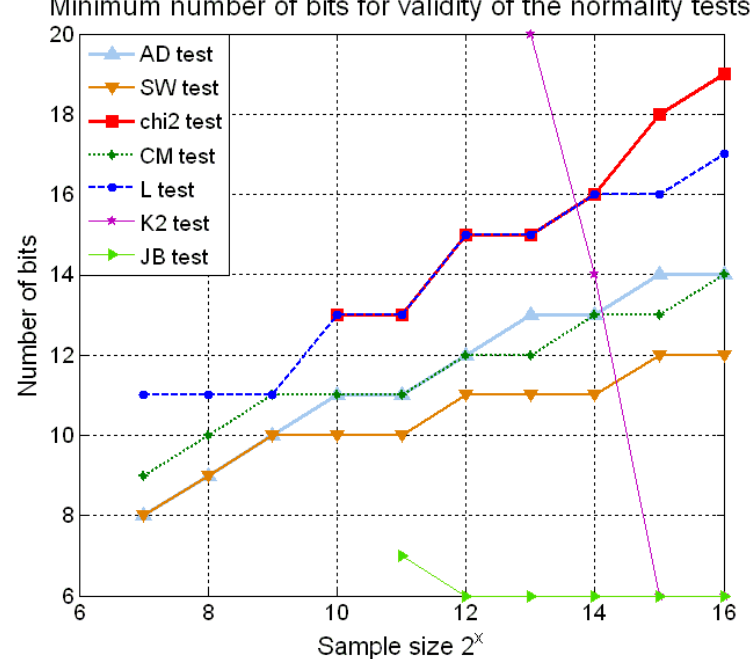
Figure 3. Minimum number of bits to neglect the quantization error, ECDF based test need more quantization bits as the sample size increase. As chi2 test, K2 test and JB tests are asymptotic, do not work properly for a low sample size. K, S and LM tests do not appear in graph as performance of these tests is acceptable for less than 6 quantization bits even for a sample size of 2 16